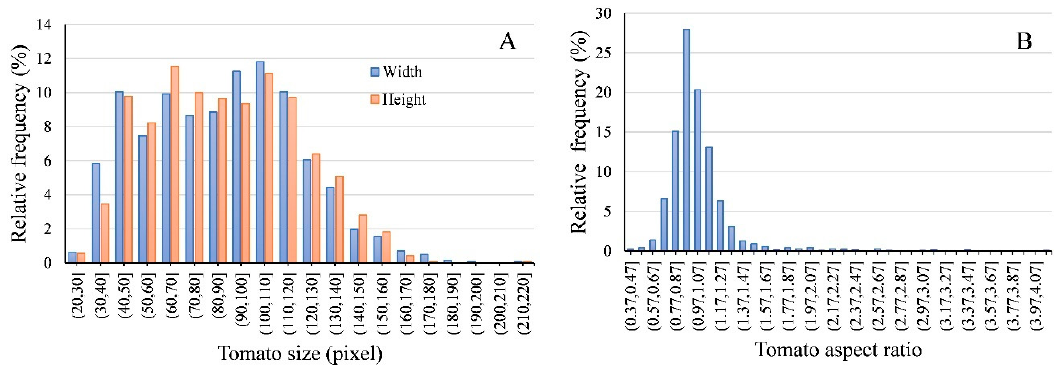
Figure 9. Relative frequency change of the tomatoes size ( A ) and aspect ratio ( B ) in images. Tomato size is represented by box width and box height. Tomato aspect ratio is calculated by width/height.